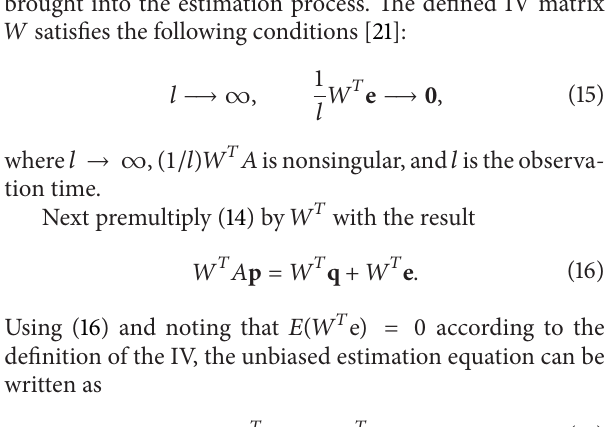
Figure 2: Photo of the rotor